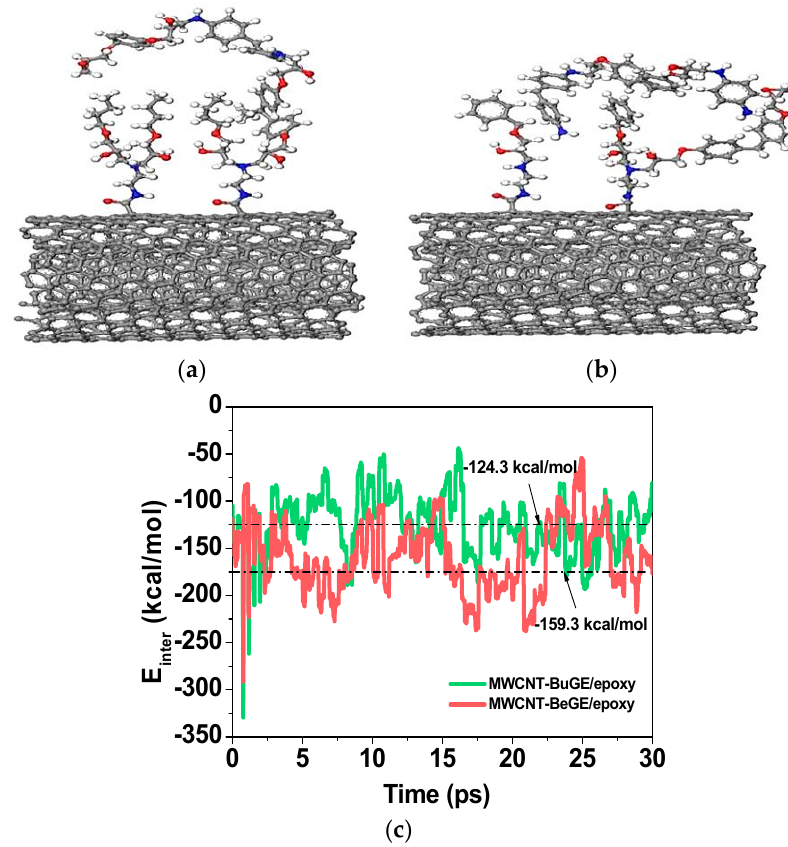
Figure 10. Schematics of interfacial microstructure of ( a ) MWCNT-BuGE/epoxy nanocomposites and ( b ) MWCNT-BeGE/epoxy nanocomposites; ( c ) the calculated intermolecular interaction energy of MWCNT-BuGE/epoxy and MWCNT-BeGE/epoxy during the relaxation process.